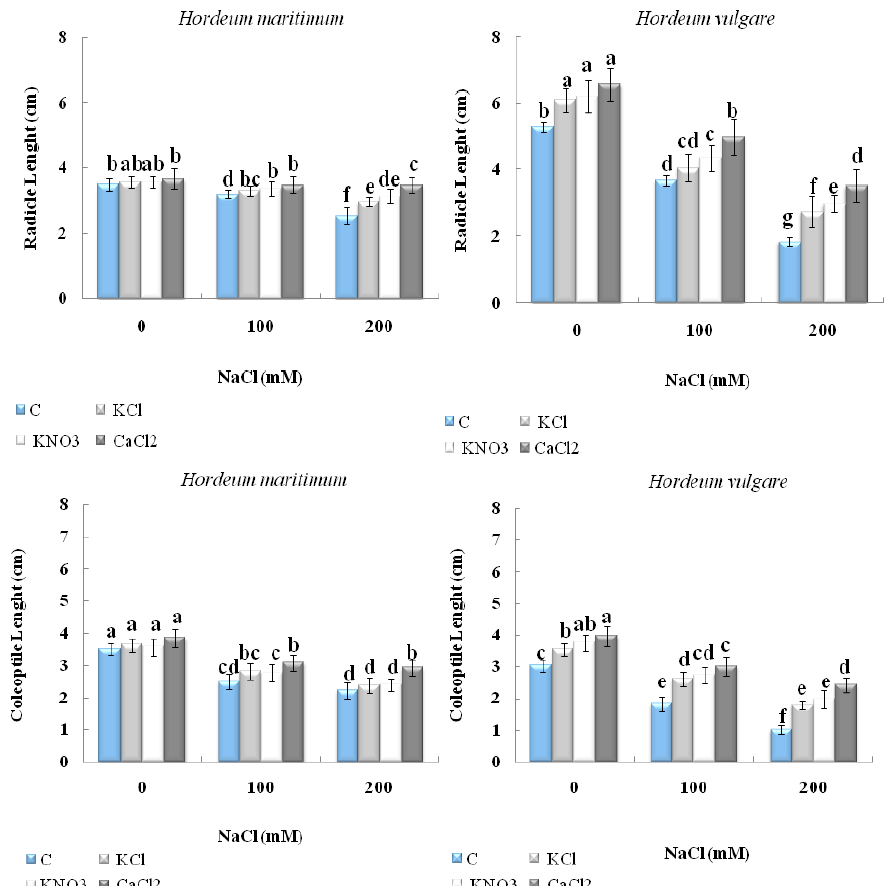
Figure 3. Effect of KCl, KNO 3 , and CaCl 2 seed priming on the radicle length and coleoptile length of two barley species, Hordeum maritimum and Hordeum vulgare (L. Manel), subjected to various salt concentrations (0, 100, and 200 mM NaCl) for 7 days at the germination stage. Values are means of 20 replicates ± standard error. Data with the same letter are not significantly different at p < 0.05 (Duncan’s test).